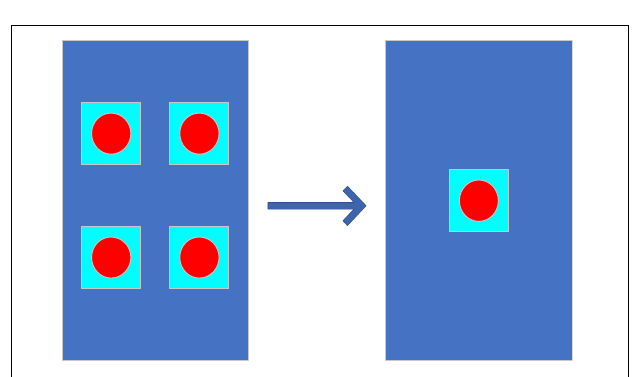
FIGURE 4 | Schematic diagram of the principle of Occam’s razor.